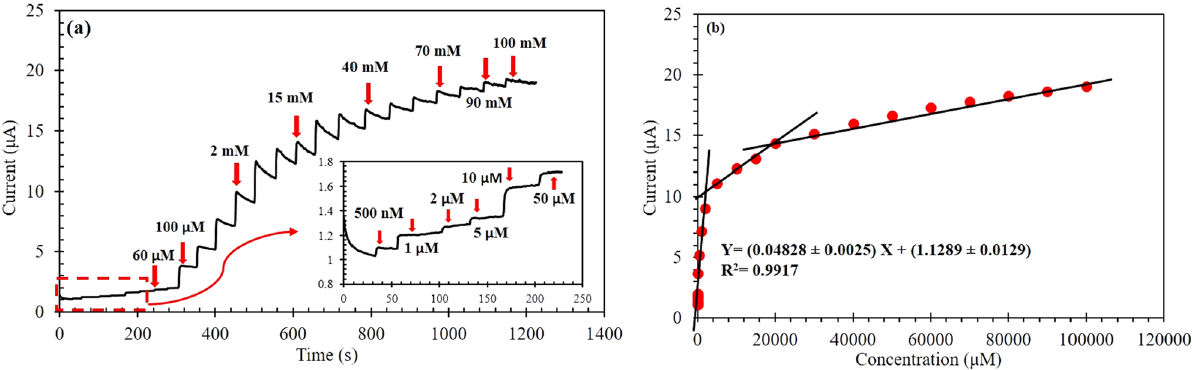
Figure 8. ( a ) Amperometric response of Nafion/CuO/ZnO-DSDSHNM/GCE at 0.60 V in 0.5 M NaOH solution by successive addition of glucose concentration from 500 nM to 100 mM. Inset: the magnified view